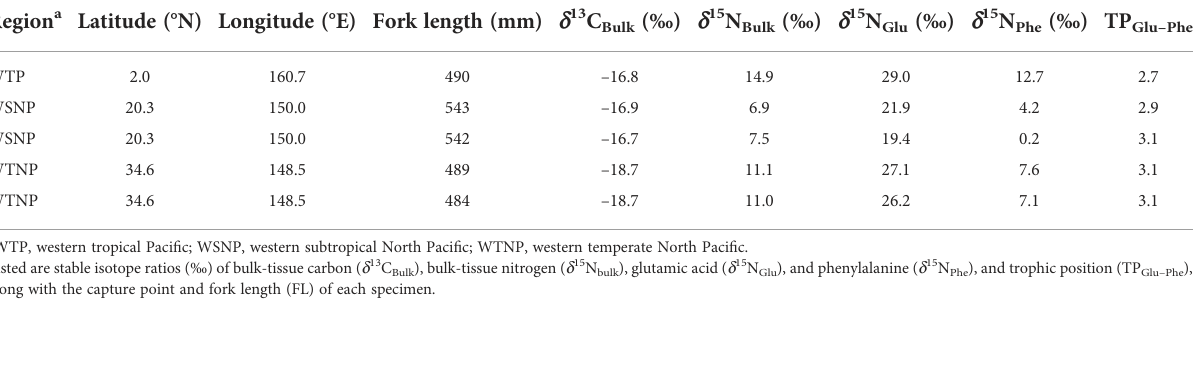
TABLE 2 Detailed sample information for fi ve skipjack tuna ( Katsuwonus pelamis ) specimens used for compound-speci fi c isotope analysis.